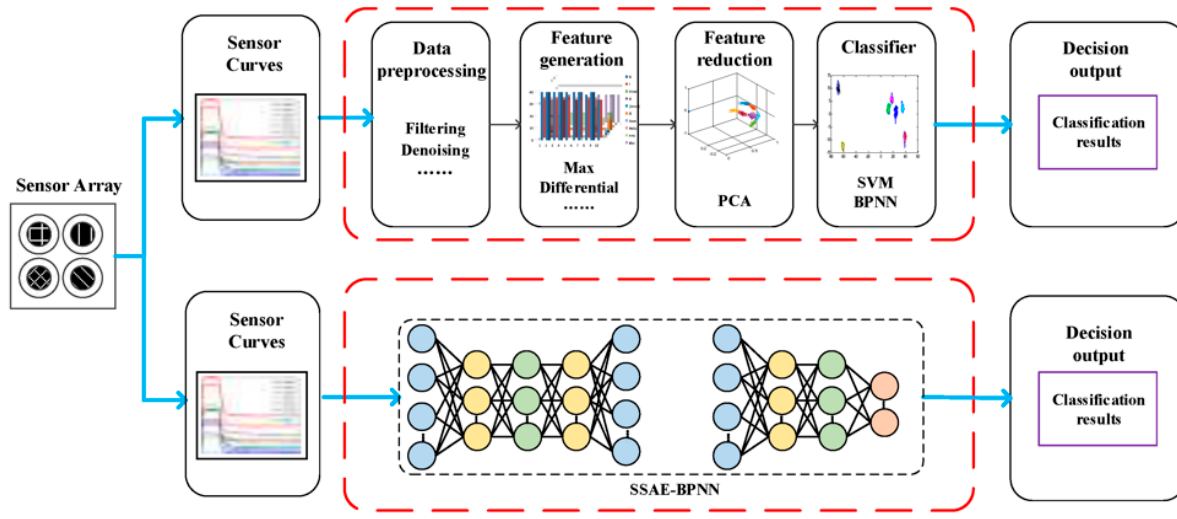
Figure 5. Autoencoder for feature extraction [62].